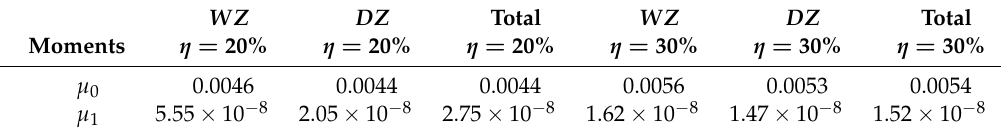
Table 2. Quantitative relative errors in the zeroth and first order moments for the product kernel. WZ DZ Total WZ DZ Total Moments η = 20% η =